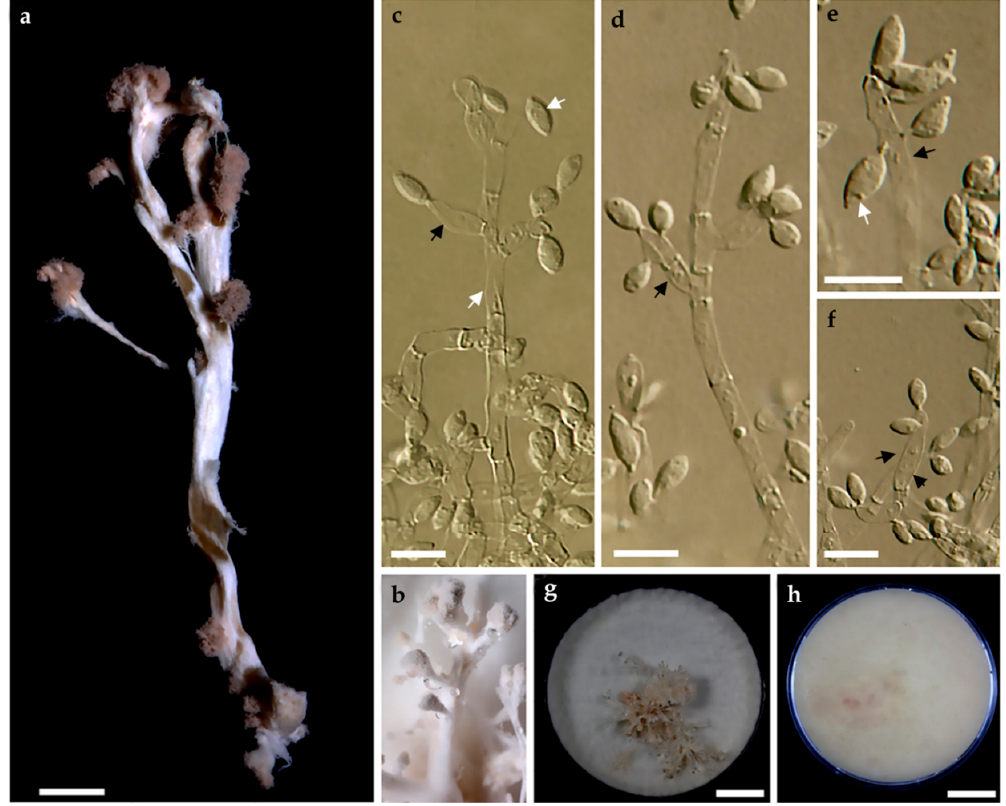
Figure 2. Culture characteristics and lindquistia–like anamorph of Stromatoneurospora phoenix strain BCC82040; ( a ): mature synnema in culture; ( b ): young synnema in culture; ( c – f ): conidiogenous cells (indicated by black arrows) and conidia; conidiophore indicated in d by white arrow; ( g , h ): colony on OA after one month. Scale is indicated by bars: ( a ) scale bar = 2 mm; ( c – f ) scale bar = 10 µm; ( g , h ) scale bar = 2 cm).